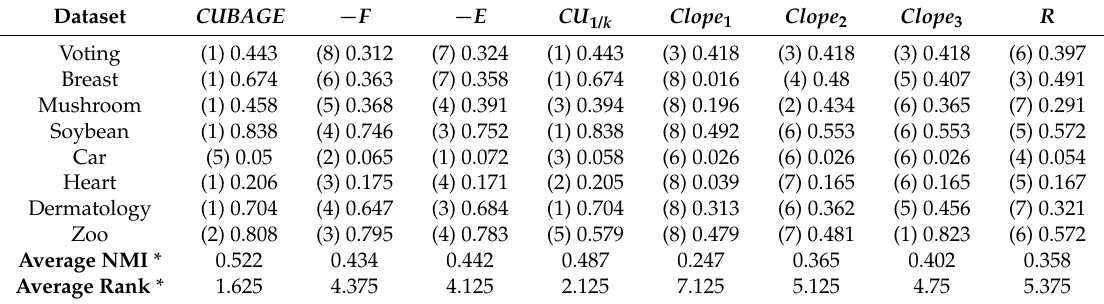
Table 8. Average NMI values of the chosen k -modes partitions over 100 runs ( k ranging from